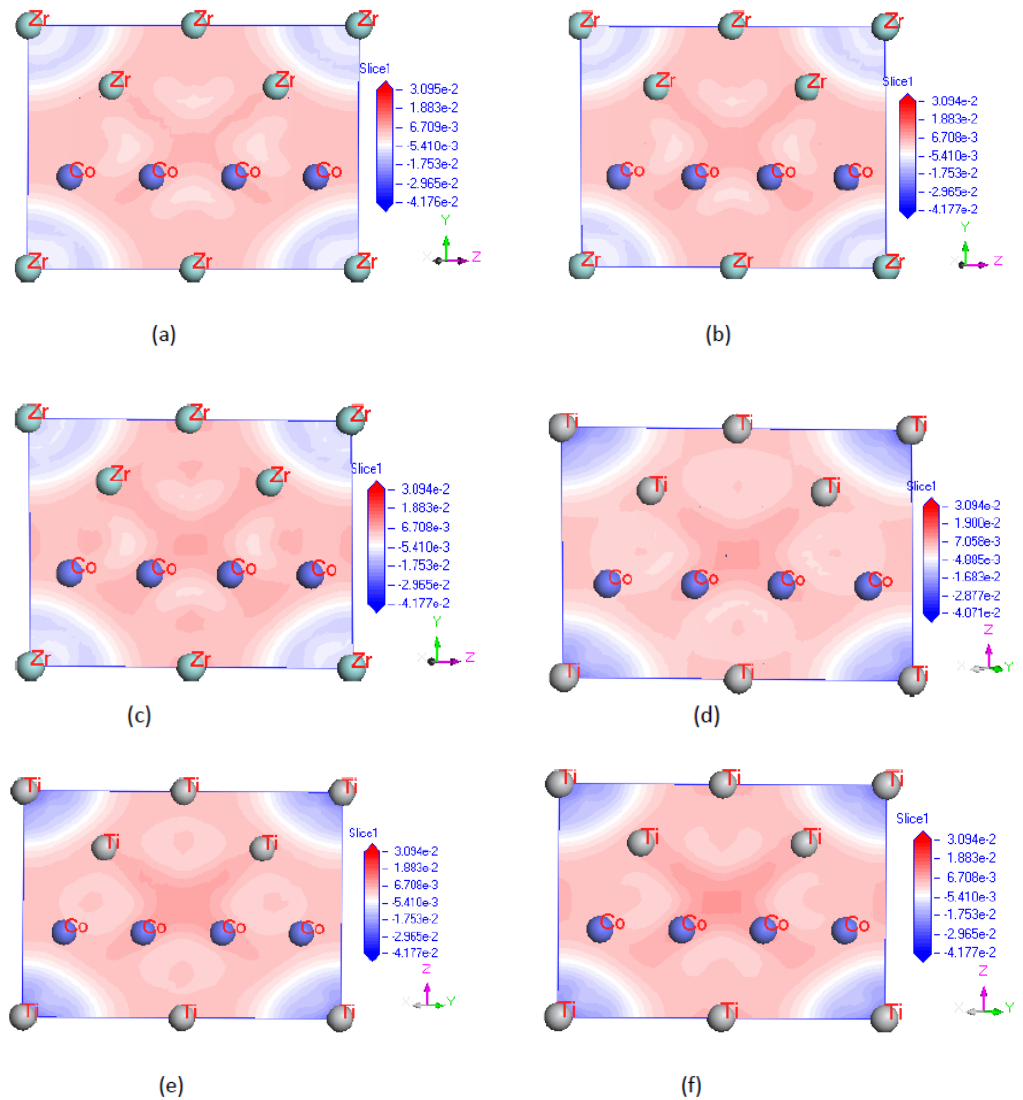
Figure 8. (color online) The electron density difference in the (110) plane of Co 2 Zr at ( a ) 0, ( b ) 10, and ( c ) 30 GPa; and that of Co 2 Ti at ( d ) 0, ( e ) 10a, and ( f ) 30 GPa, isosurface value: 0.1 e/Å 3 .